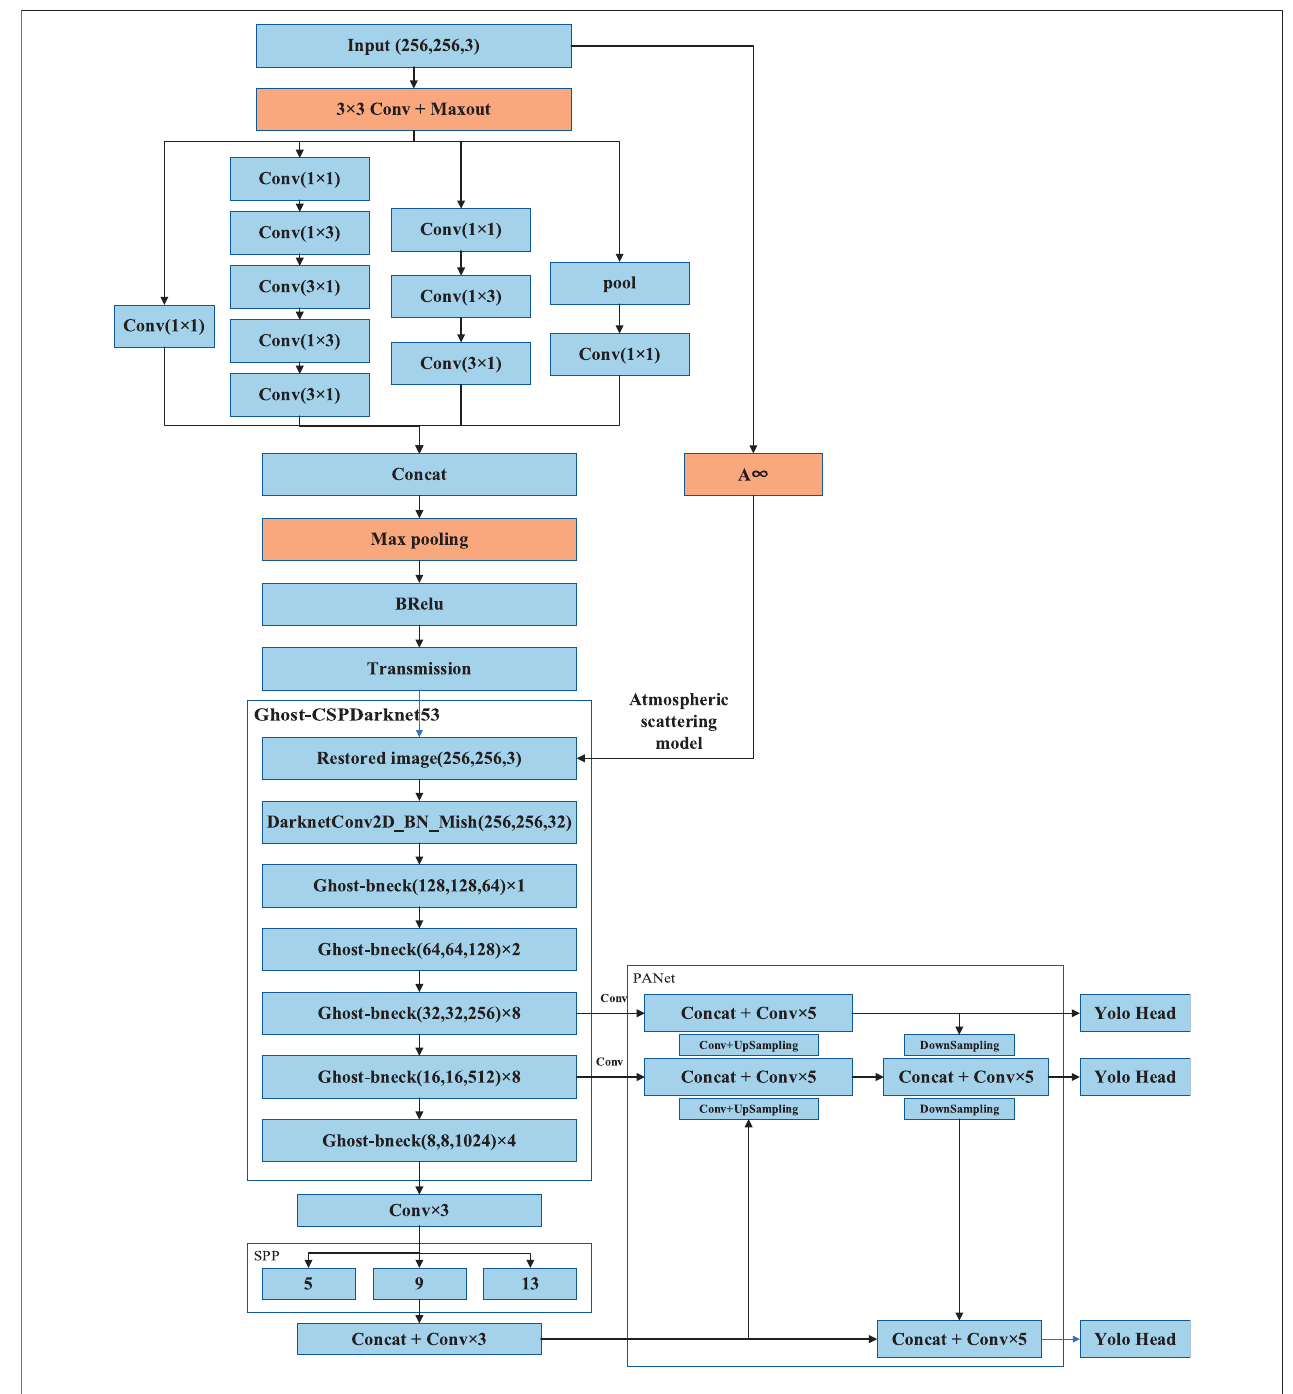
FIGURE 8 | Framework of crack detection model in